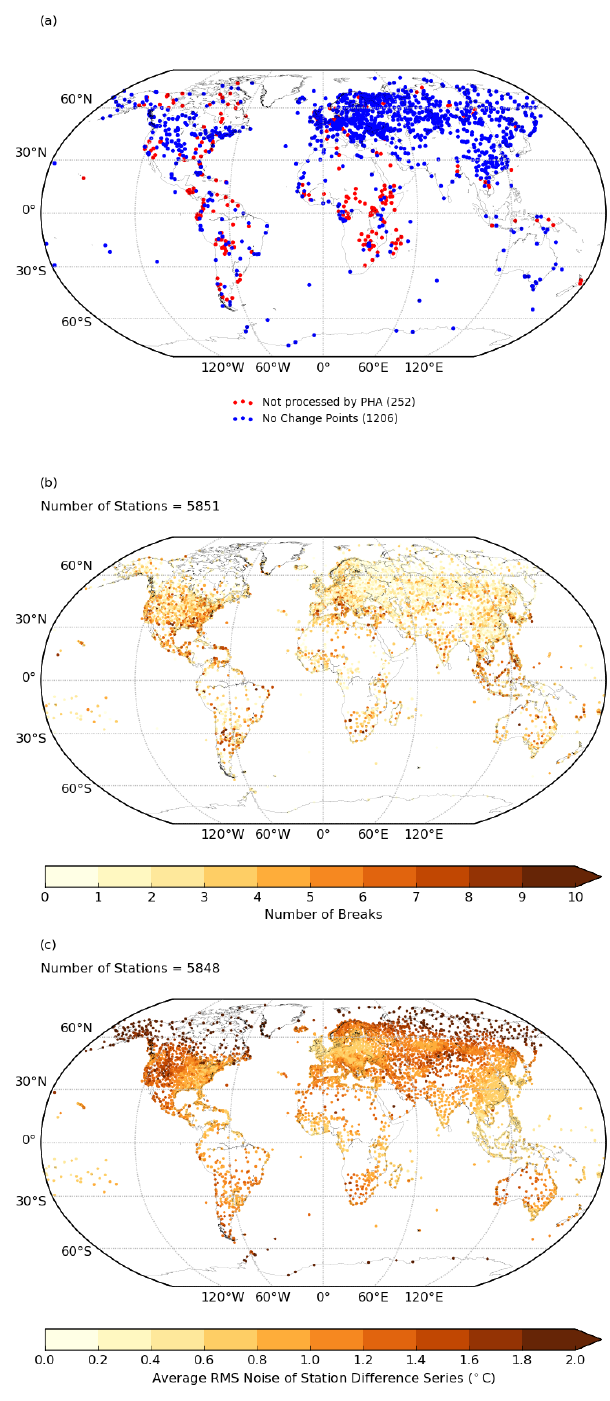
Figure 1. (a) Stations where temperatures could not be processed Fig. 1. (a) Stations where temperatures could not be processed by by PHA (red) and those stations where no temperature change point PHA (red) and those stations where no temperature change point was found in the entire record (blue). (b) The number of change was found in the entire record (blue). (b) The number of change points detected for each station. (c) The average rms difference for points detected for each station. (c) The average RMS difference the neighbours from each station for the monthly-average tempera- for the neighbours from each station for the monthly average tem- peratures.